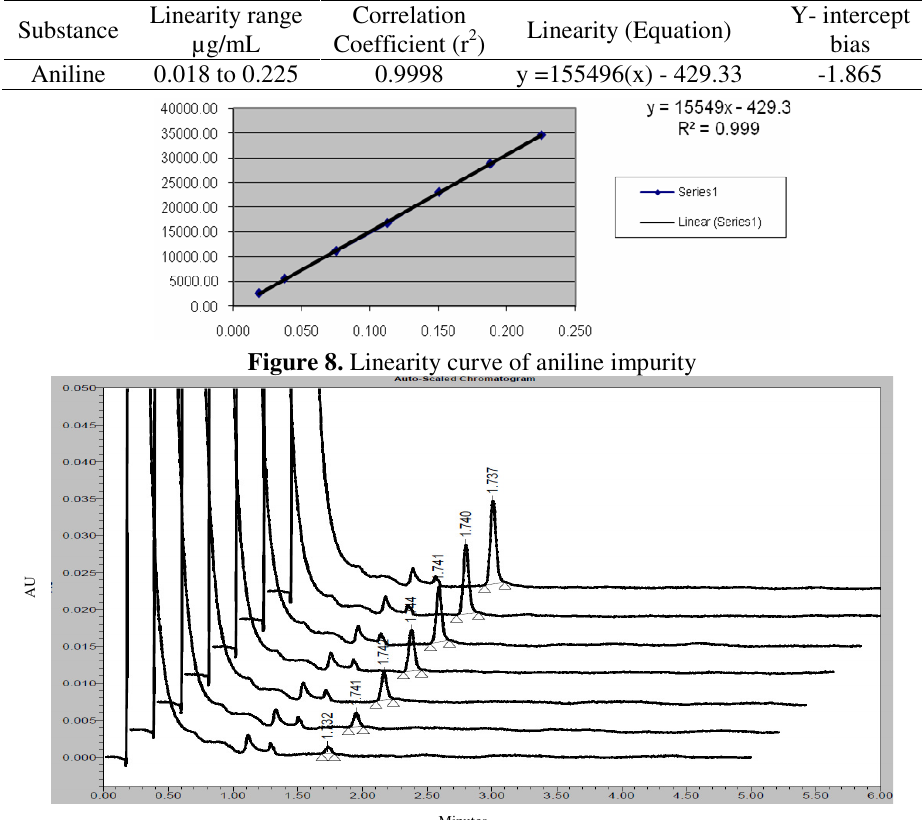
Table 5. Linearity results (determined on LOQ, 25, 50, 75, 100, 125 and 150%)